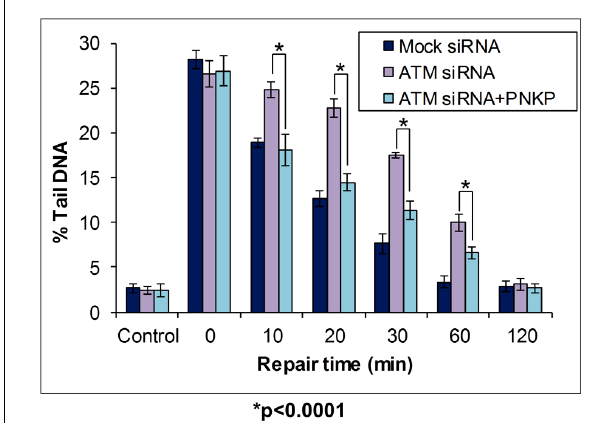
FIGURE 6 | Modulation of BER through Cul4A–DDB1–STRAP- dependent regulation of PNKP protein levels, as revealed by the in-gel DNA repair comet assay. HCT116p53 + / + cells were treated in the absence or presence of ATM siRNA for 24 h. Cells were then further treated in the absence (Mock siRNA and ATM siRNA) and presence (ATM siRNA + PNKP) of a mammalian expression plasmid expressing Flag-tagged PNKP for a further 24 h. Cells were analyzed using the in-gel DNA repair comet assay following treatment in suspension with 35 μ M hydrogen peroxide for 5 min, and allowing for DNA damage repair. Mean % tail DNA values with SDs were calculated. Further details are provided in Figure 4 legend. Statistically significant results comparing ATM siRNA versus ATM siRNA-treated cells transfected with a plasmid containing Flag-tagged PNKP are represented by * p < 0.0001, as analyzed by Student’s t -test. Data taken and modified from Parsons etal.